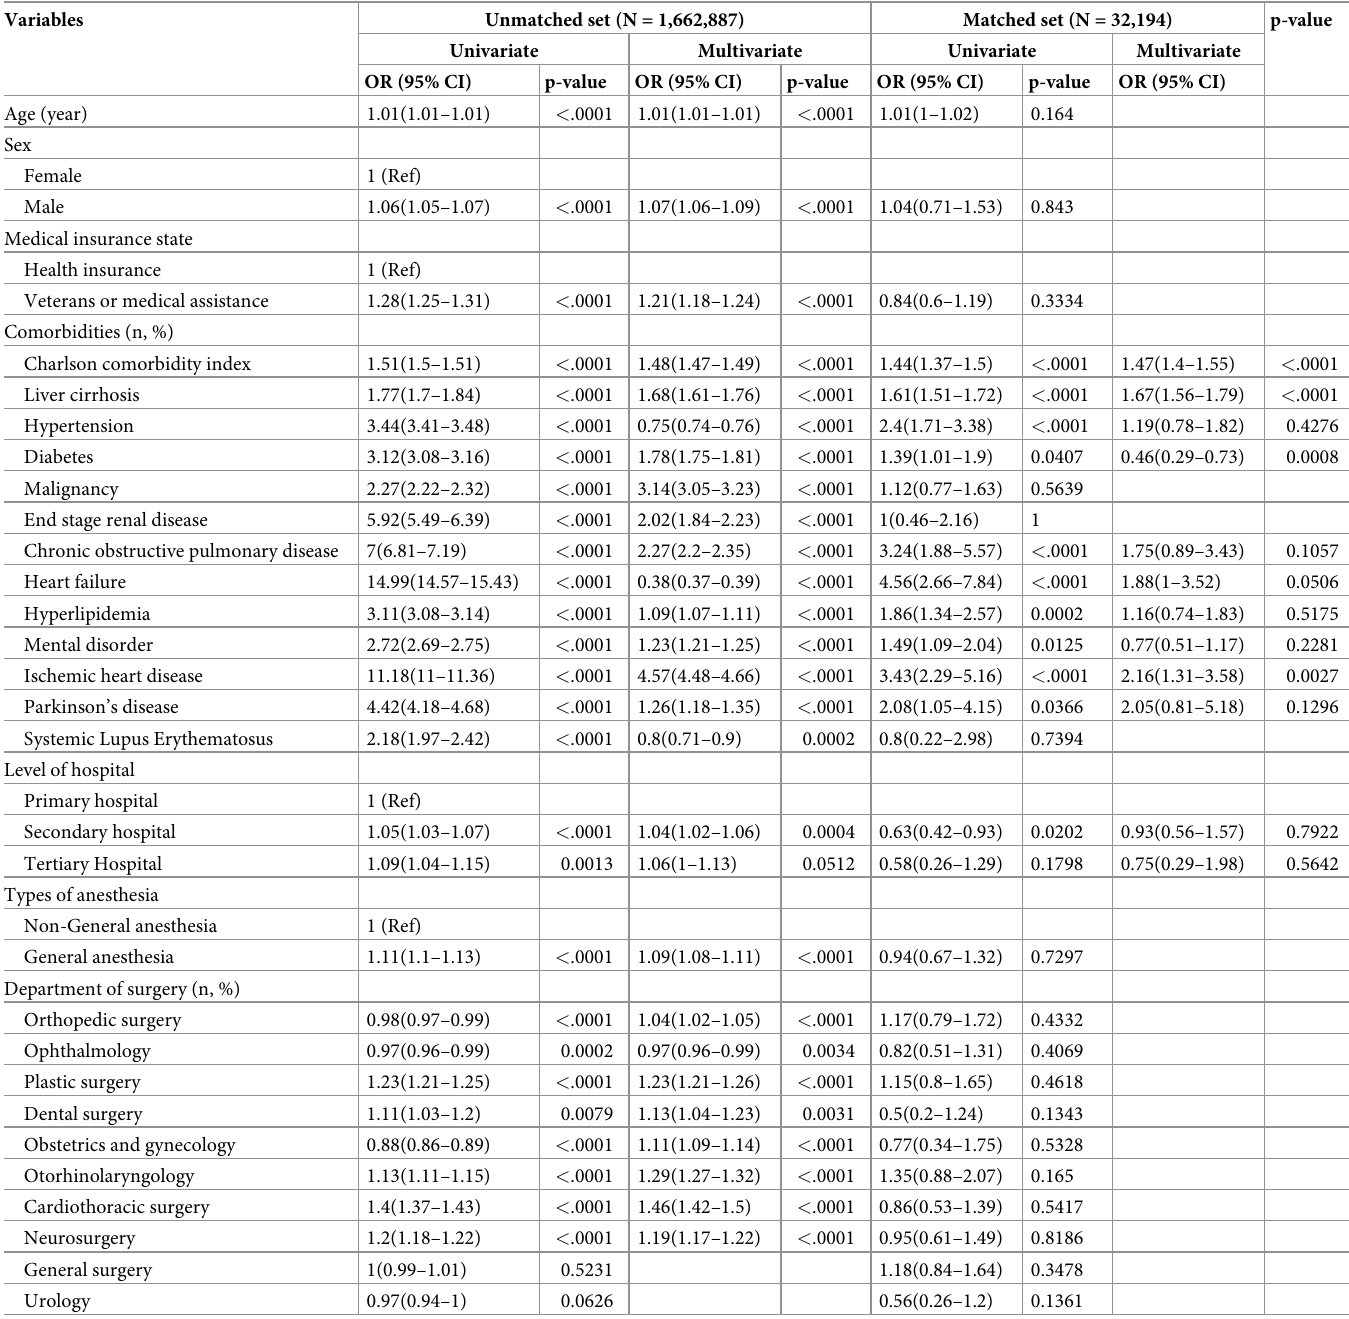
Table 4. Multivariate logistic regression predicting adverse outcome (mortality or post-operative complication) of all